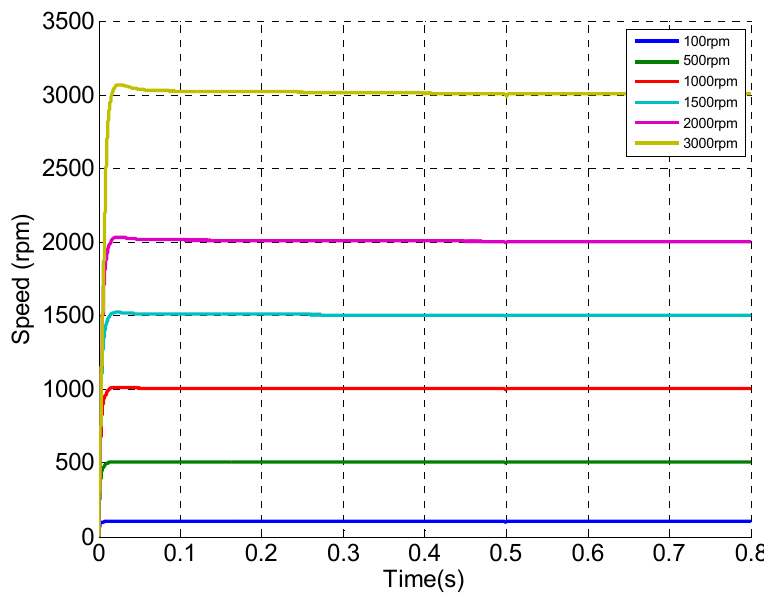
Energies 2019 , 11 , x FOR PEER REVIEW